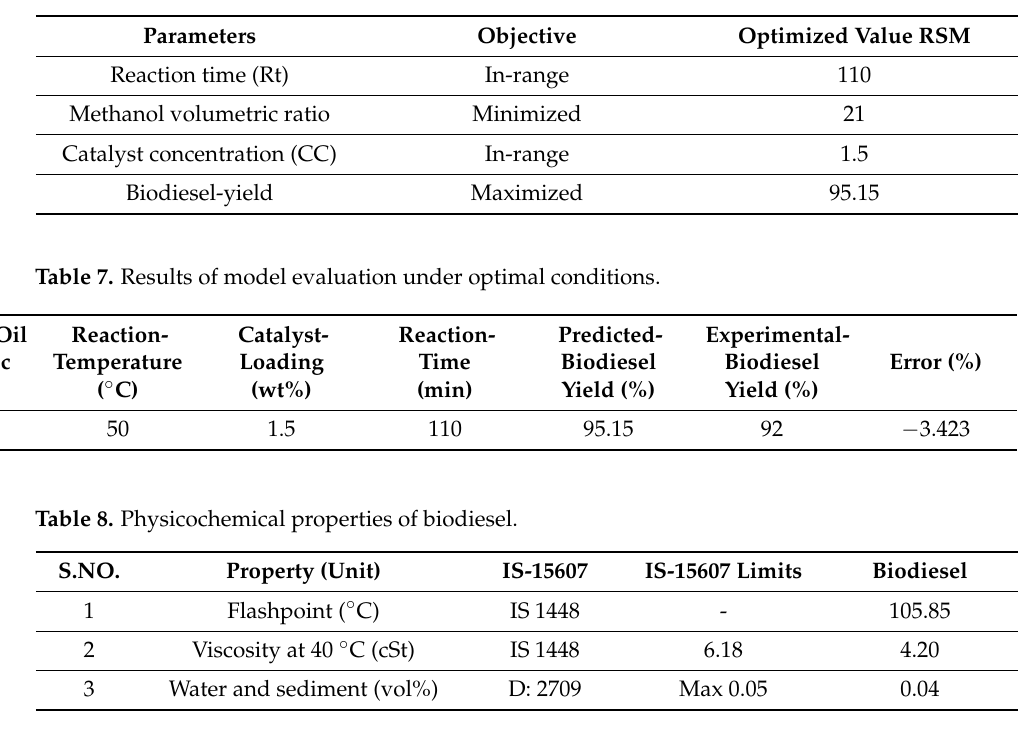
Table 6. Optimizing for optimum possible biodiesel production.